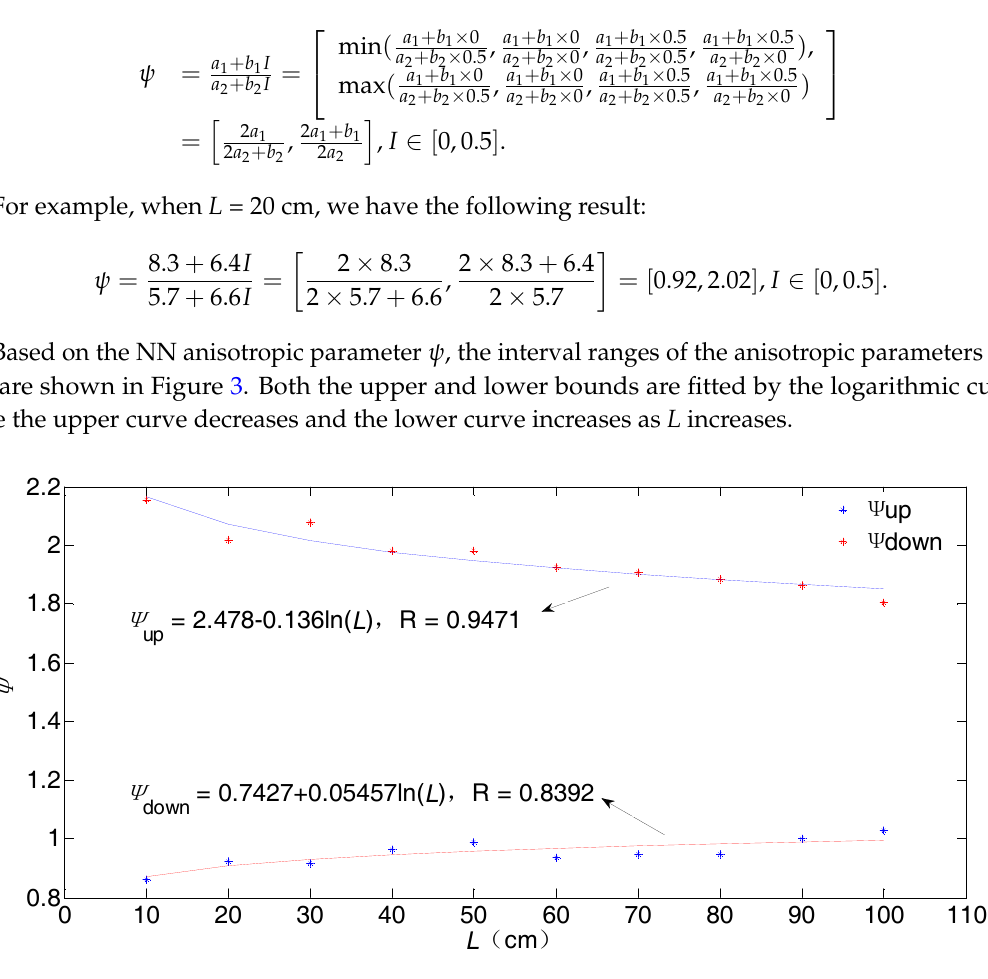
Figure 3. The upper and lower bounds of the parameter ψ for different sized joint samples.